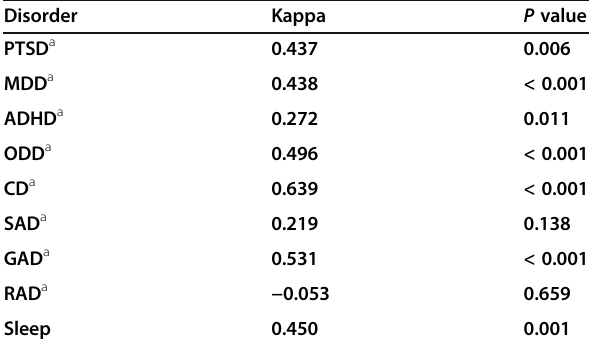
Table 4 Validity using kappa for each psychiatric disorder diagnosed by DIPA in comparison to the CBCL